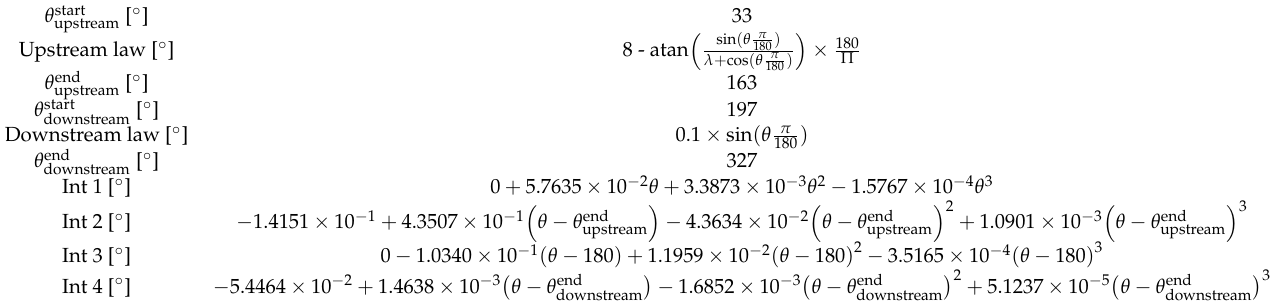
Table A2. Details of pitching law PL2 ( θ is always in degrees ( ◦ ) in the